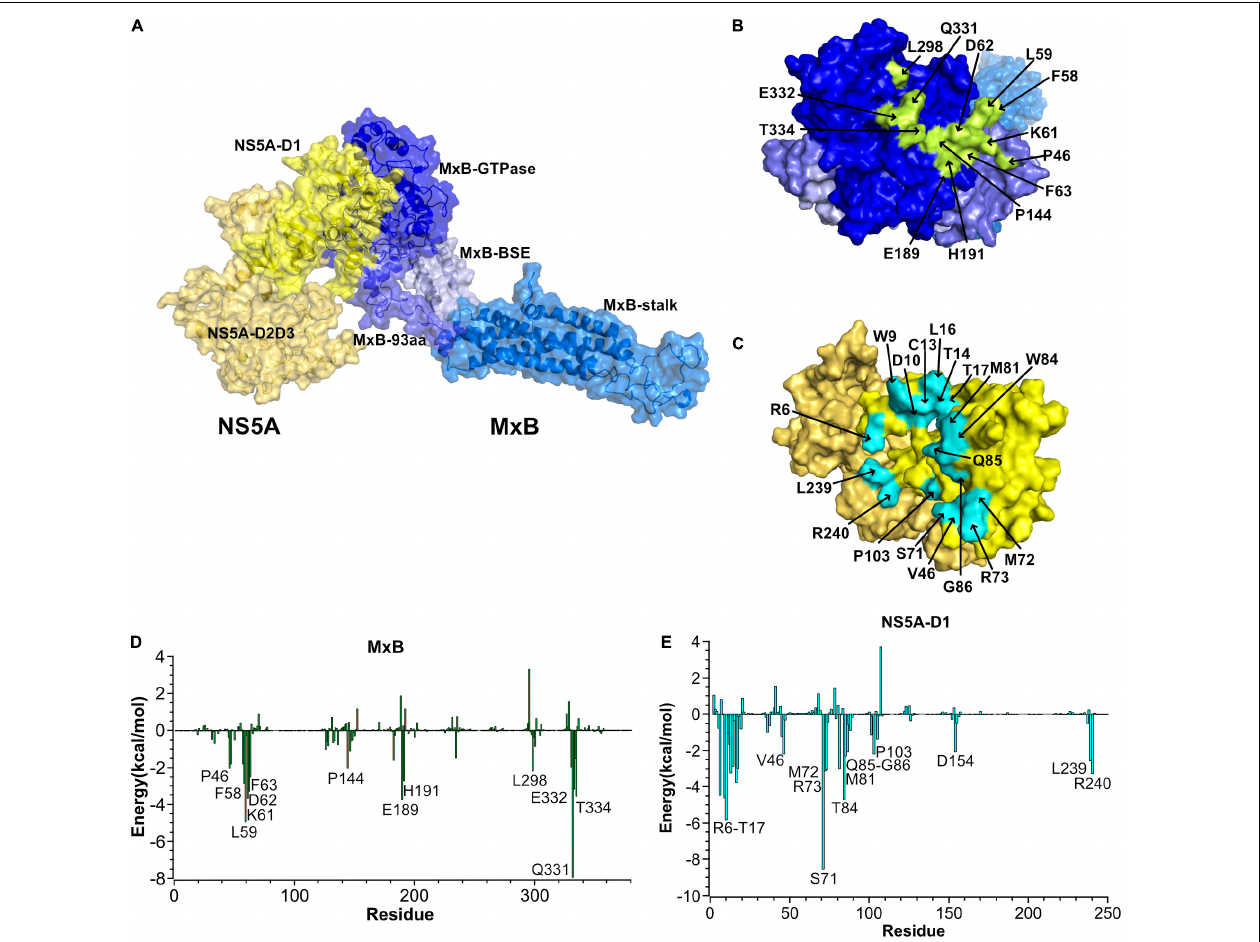
FIGURE 2 | Predicted MxB–NS5A interaction sites. (A) Cartoon and surface representation of the most representative structure of MxB (blue) in complex with NS5A (yellow). NS5A uses its domains I (NS5A-D1) to bind to the GTPase domain of MxB. (B,C) Surface representations of interacting residues in MxB (top) and NS5A (bottom). The identified hot-spot residues in MxB and NS5A are labeled and highlighted in green and blue in the surface representations, respectively. (D,E) The per-residue contribution to the MxB:NS5A-D1 binding energy (kcal/mol). Only residues with total energies above 2 kcal/mol are labeled. NS5A, non-structural protein 5A; MxB, myxovirus resistance B.